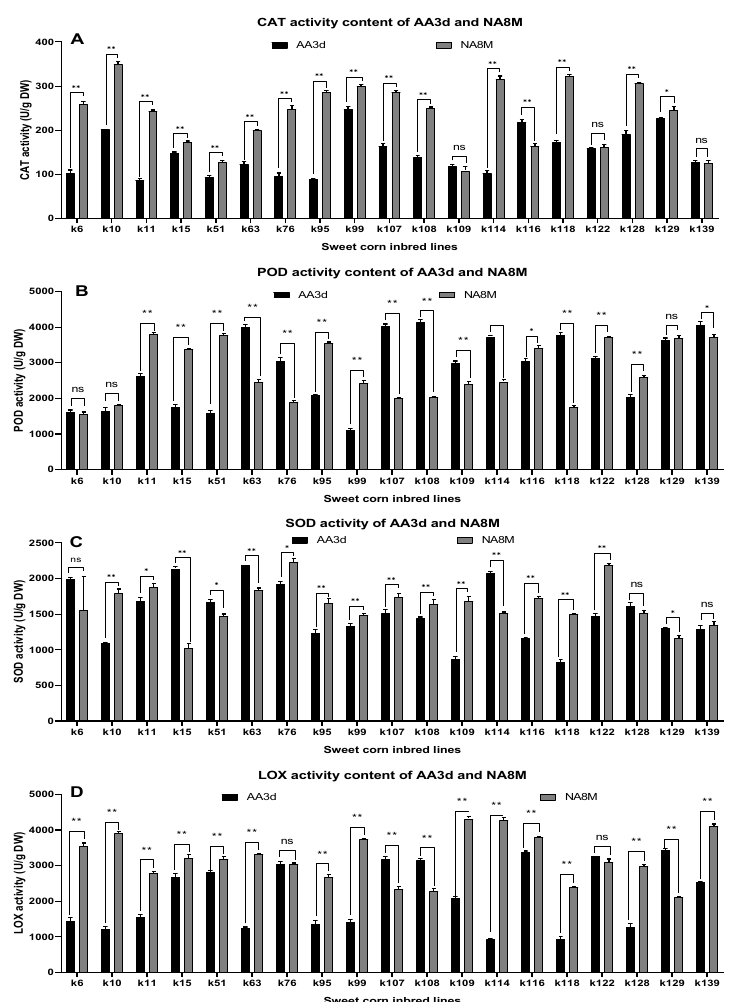
Figure 5. Comparative analysis of CAT, POD, SOD and LOX activities in AA3d and NA8M seeds in 19 sweet corn lines. ‘ns’, * and ** indicate p > 0.05, p ≤ 0.05 and p ≤ 0.01, respectively. ( A ), ( B ), ( C ) and ( D ) indicate the CAT, POD, SOD and LOX activities of AA3d and NA8M, respectively.